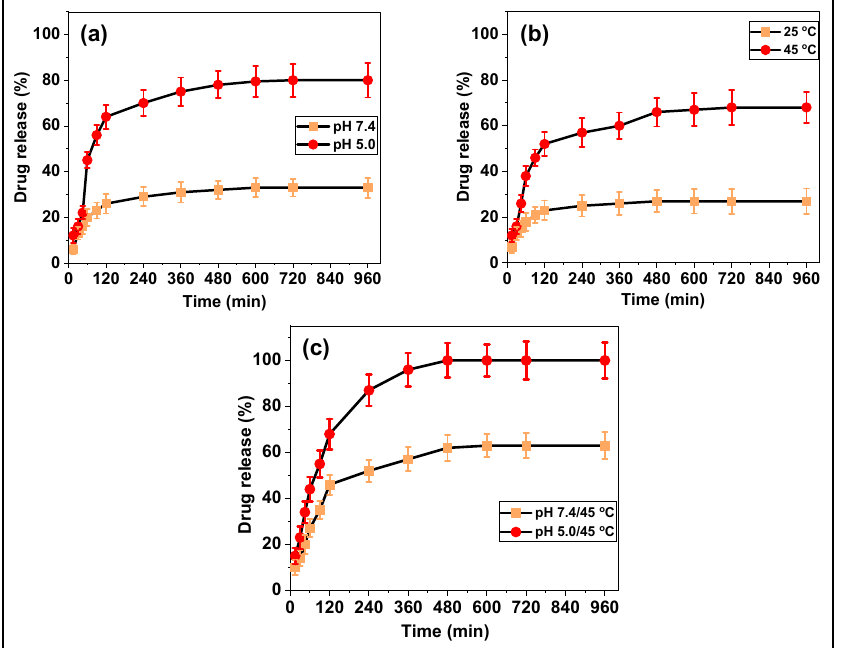
Figure 5. In vitro Cur delivery of PNIPAm-co-PAAm-Mela/Cur HG system. ( a ) Cur release at different pH, ( b ) Cur release at different temperature stimuli, and ( c ) Cur release with the combined pH and temperature conditions, respectively. Mean with error bar n = 3. Table 1. Cur release efficiency from PNIPAm-co-PAAm-Mela HG system at different temperatures. Sample